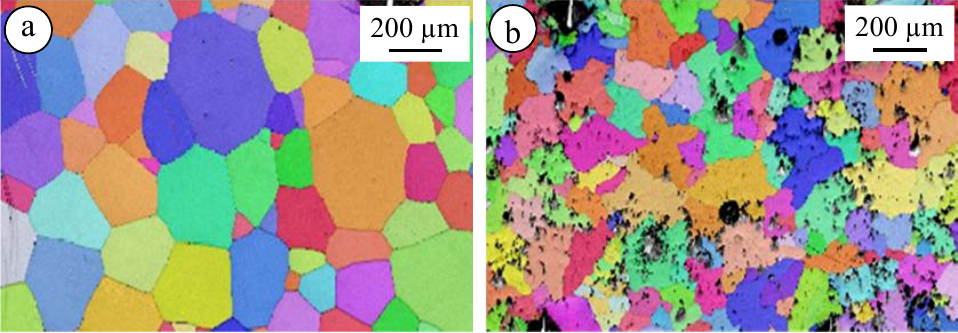
Figure 13. EBSD images of: ( a ) El 21; and ( b ) El21–1%AlN after solution treatment at 520 °C.